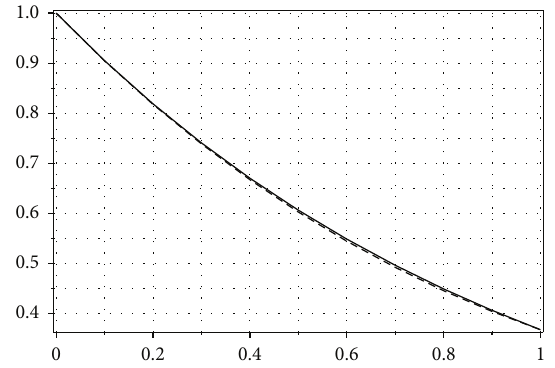
Figure 6: Comparison between exact and approximate solutions of Example 4 for 𝑘 = 2 . Solid line represents exact solution and dash line represents approximate